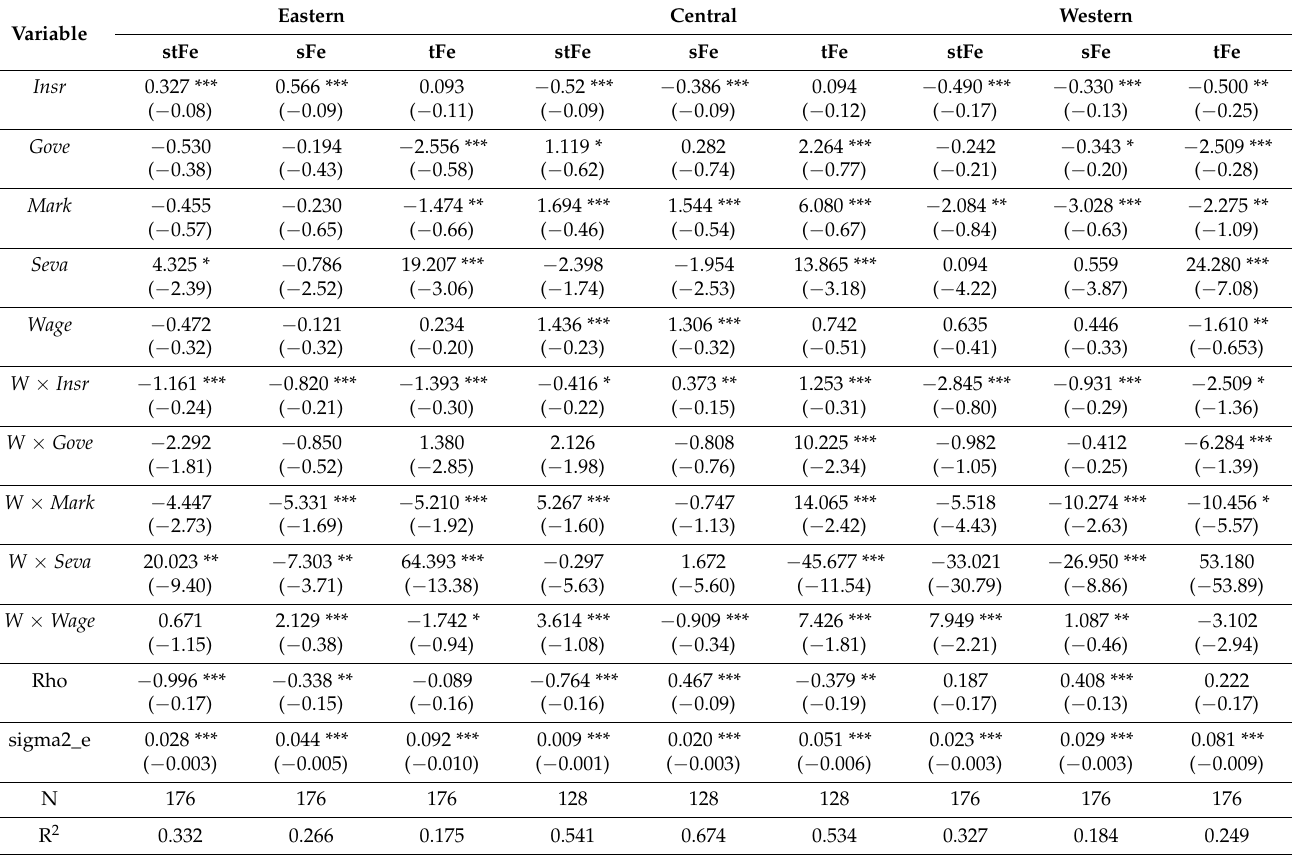
Table 7. Regression results of spatial models in different